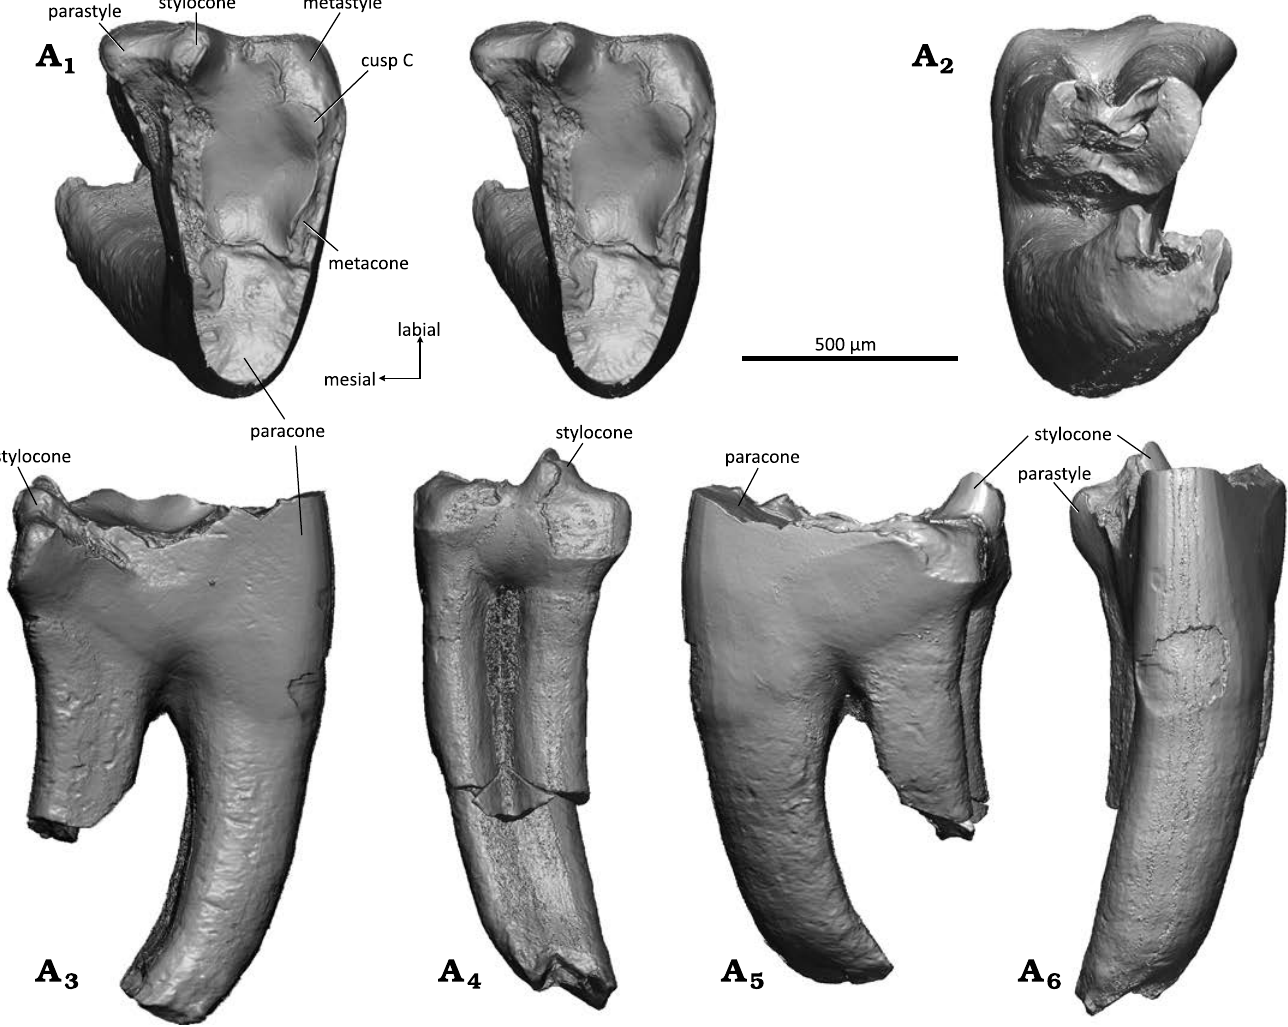
Fig. 7. Dryolestid mammal Minutolestes submersus gen. et sp. nov., WMNM P82304 from Busche Quarry near Balve, North Rhine-Westphalia, Germany, Barremian–Aptian (Lower Cretaceous). Left upper molar in occlusal (stereopair, A 1 ), dorsal (A 2 ), mesial (A 3 ), labial (A 4 ), distal (A 5 ), and lingual (A 6 )